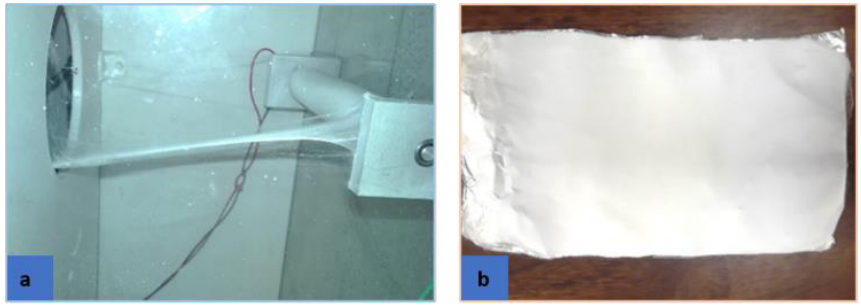
Figure 21. ( a ) Fiber mat is being formed on mandrel. ( b ) Fiber mat on an aluminum foil [171].